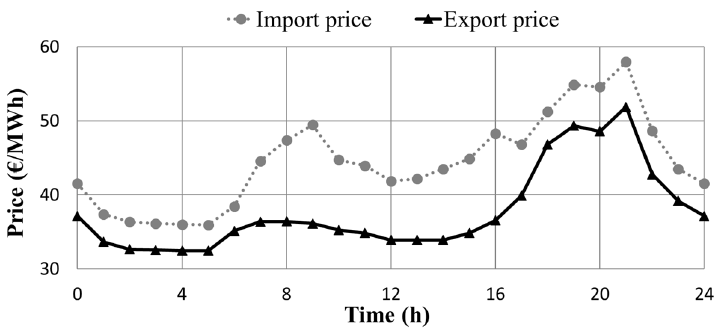
Figure 7. Hourly import and export prices.